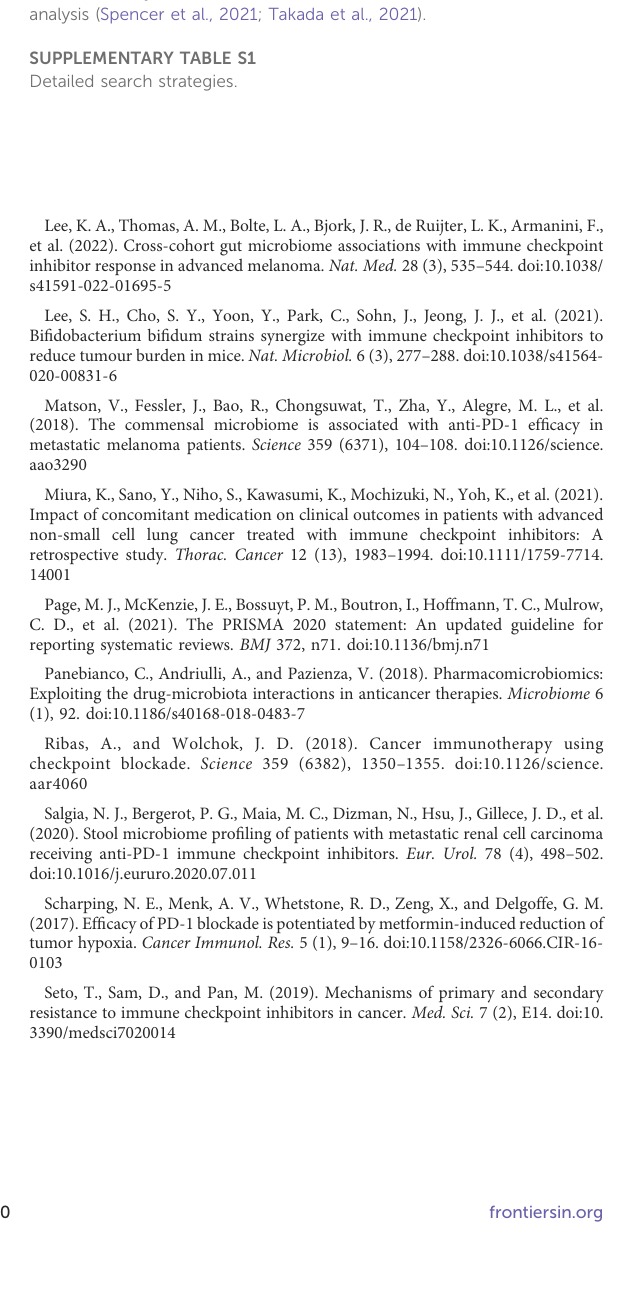
SUPPLEMENTARY FIGURE S1 Sensitivity analysis of progression-free survival. CL, Con fi dence interval; Univariate analysis (Dizman et al., 2022); Multivariable analysis (Svaton et al., 2020; Tomita et al., 2020; Spencer et al., 2021; Takada et al., 2021). SUPPLEMENTARY FIGURE S2 Sensitivity analysis of overall survival. CL, con fi dence interval; Univariate analysis (Dizman et al., 2022); Multivariable analysis (Svaton et al., 2020; Tomita et al., 2020; Takada et al., 2021). SUPPLEMENTARY FIGURE S3 Sensitivity analysis of the objective response rate. CL, con fi dence interval; Univariate analysis (Tomita et al., 2020; Dizman et al., 2022); Multivariable analysis (Miura et al., 2021; Takada et al., 2021). SUPPLEMENTARY FIGURE S4 Sensitivity analysis of the disease control rate. CL, Con fi dence interval; Univariate analysis (Tomita et al., 2020; Dizman et al., 2022); Multivariable analysis (Spencer et al., 2021; Takada et al., 2021). SUPPLEMENTARY TABLE S1 Detailed search